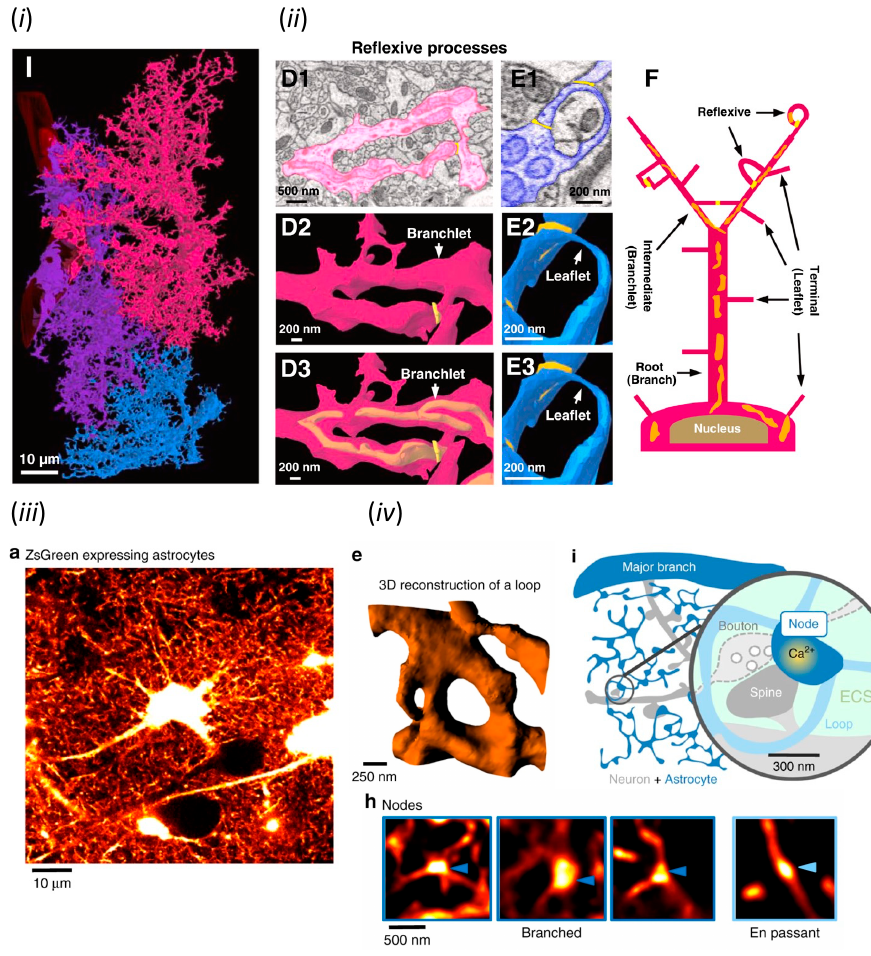
Figure 1. Structural studies of astrocytes by modern microscopy. ( i ) Astrocytic domain and ( ii ) reflexive process visualized by SBF-SEM. ( i ) and ( ii ) were adapted with permission from Figure 1 and Figure 2 in Aten et al., 2022 [7], respectively. ( iii ) In vivo astrocytes and ( iv ) their fine processes including node and sponge-like form visualized by STED microscopy. ( iii ), ( iv ) e and ( iv ) h were adapted with permission from Figure 1, while ( iv ) i was from Figure 8 in Arizono et al., 2020 [9], respectively.